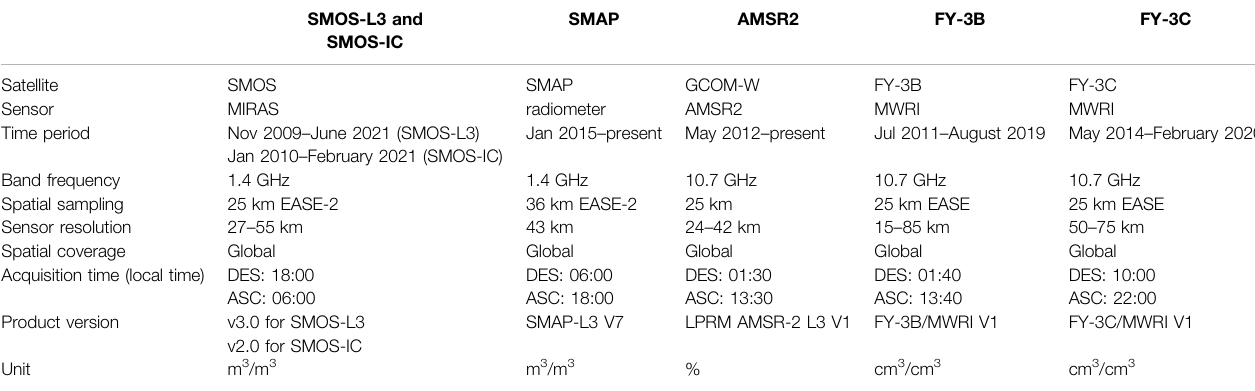
TABLE 1 | Overview of remote sensing – based soil moisture products.